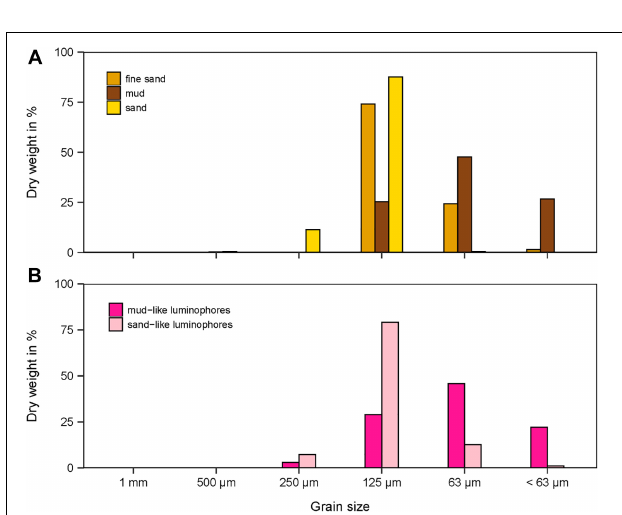
FIGURE 4 | (A) Grain size distribution in dry weight (DW) in% of the three different sediments and (B) the luminophores used.